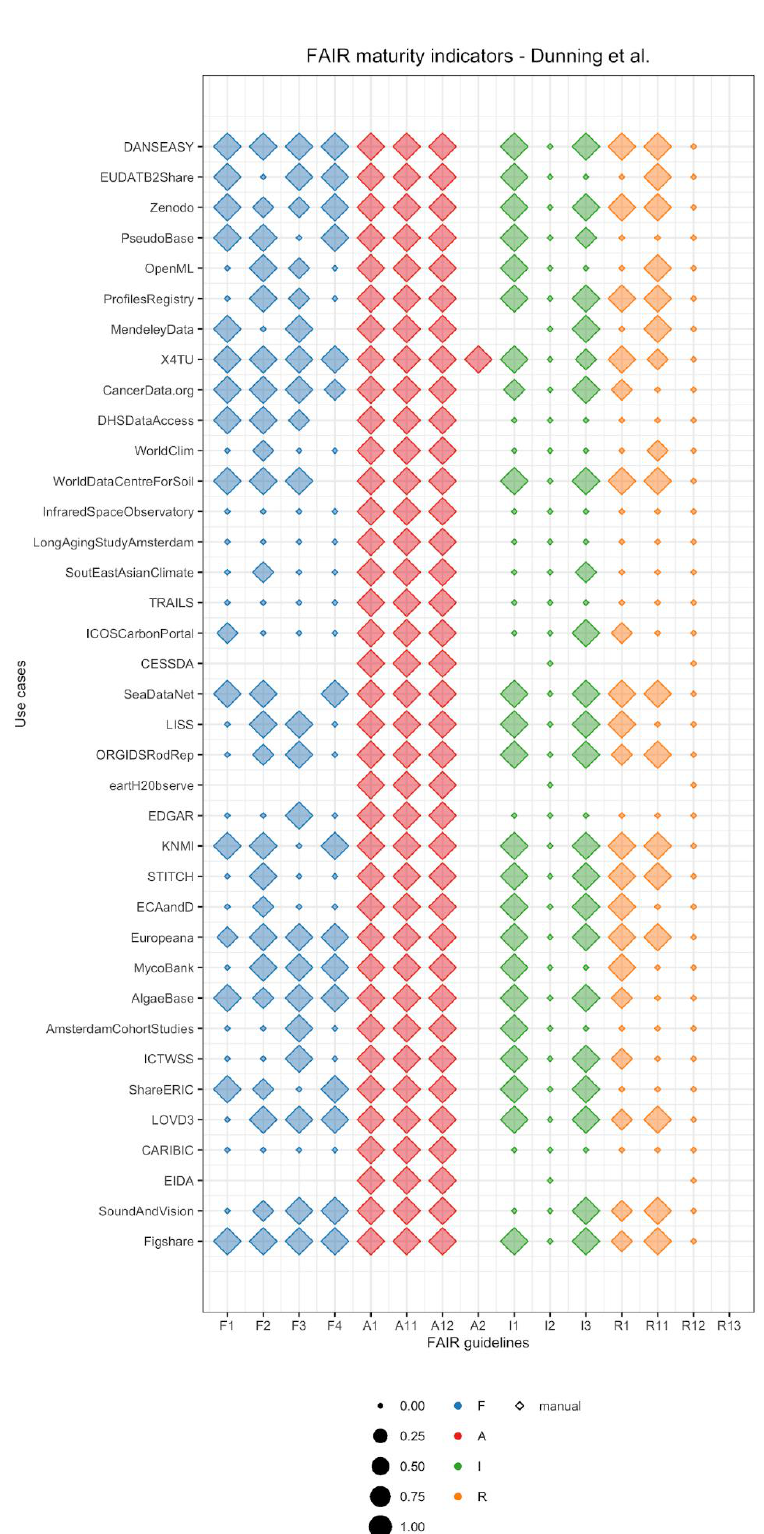
Figure 2. FAIR balloon plot for the repositories analyzed by Dunning et al. [17] (data available at their institutional repository). From their quantitative scores, we converted “complies completely” to 1, “just about / maybe not” to 0.5, and “fails to comply” to 0. We did not assign any value to “unclear”, which is thus represented as missing elements. The graph can be fully reproduced from our Jupyter Notebook on GitHub and interactively in binder.